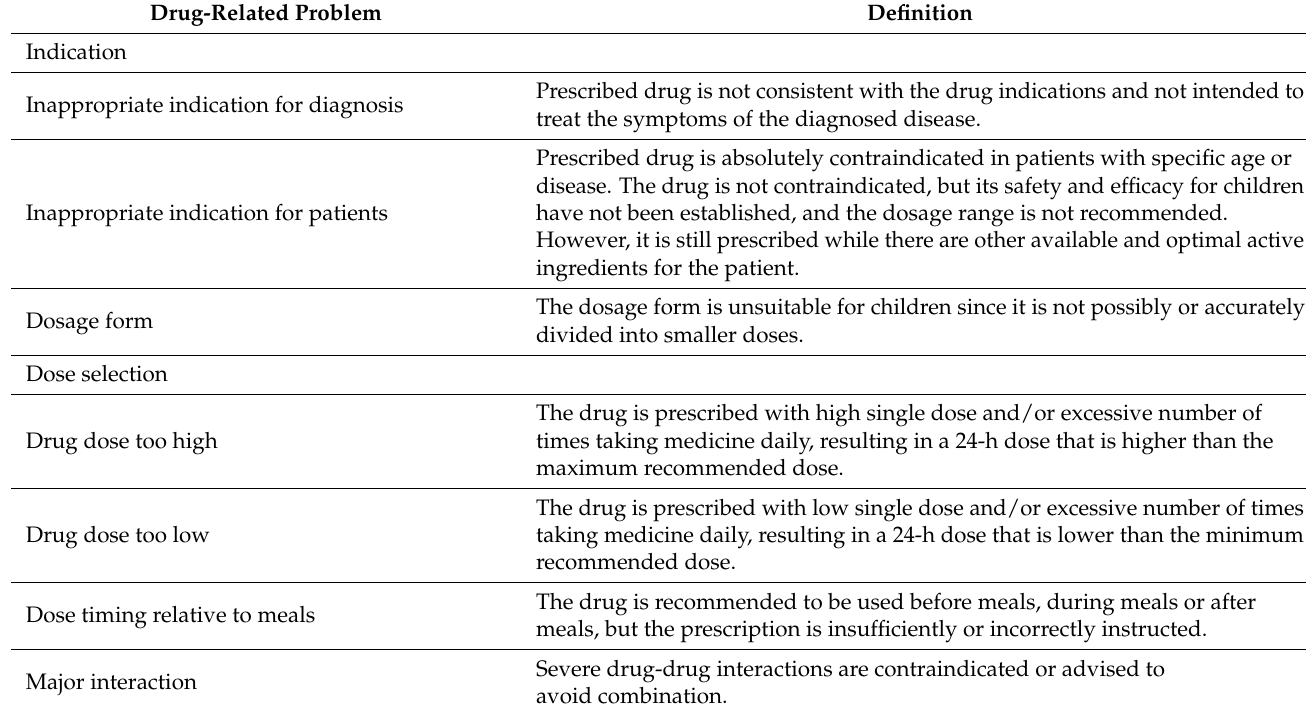
Table 1. Criteria for drug-related problems (DRPs)